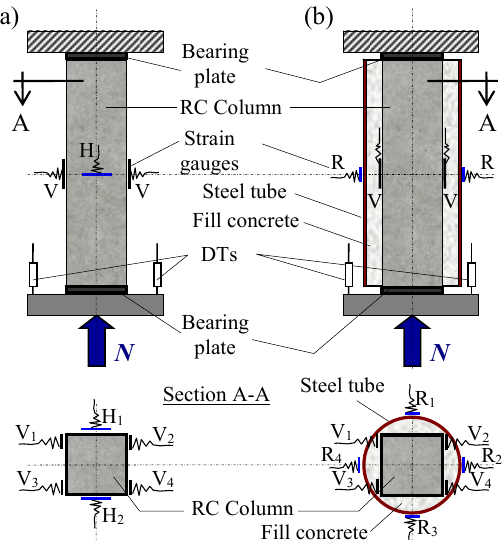
Figure 3. A schematic view of the test setup: plain RC column ( a ) and strengthened column ( b ).